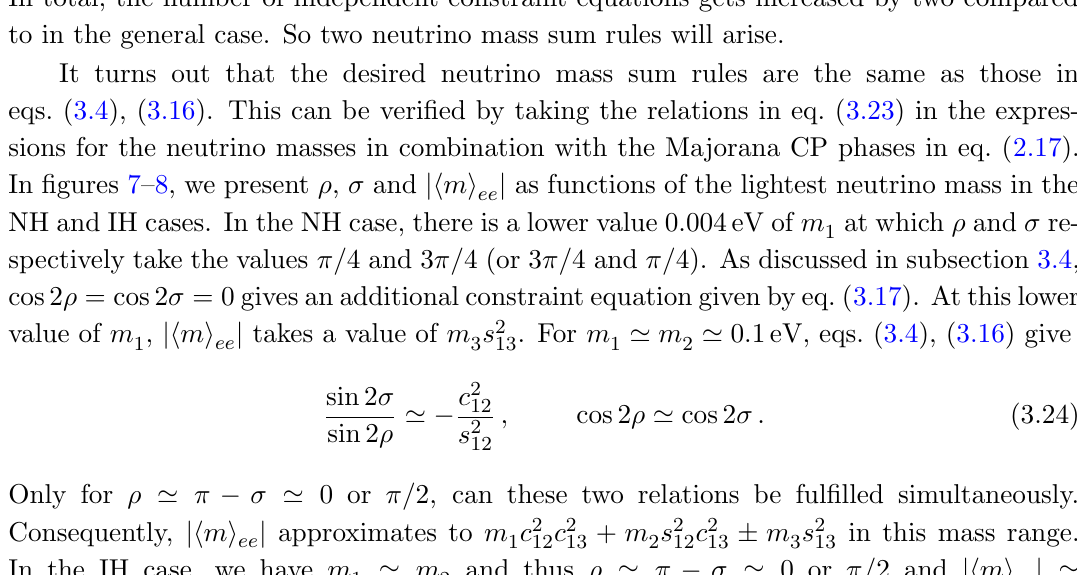
Figure 7 . (cid:26) and (cid:27) as functions of the lightest neutrino mass ( m case) in the case of two sides of equations A, D, E and G being